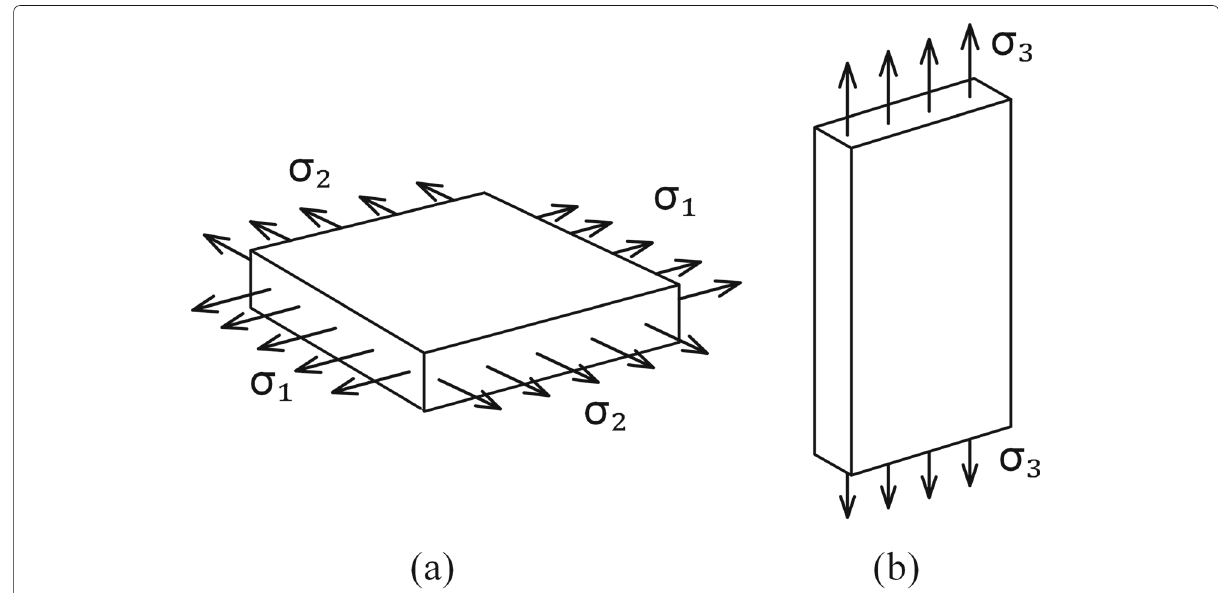
Fig. 2 Special states of stress. a Equi-bi-axial stress. b Uni-axial stress